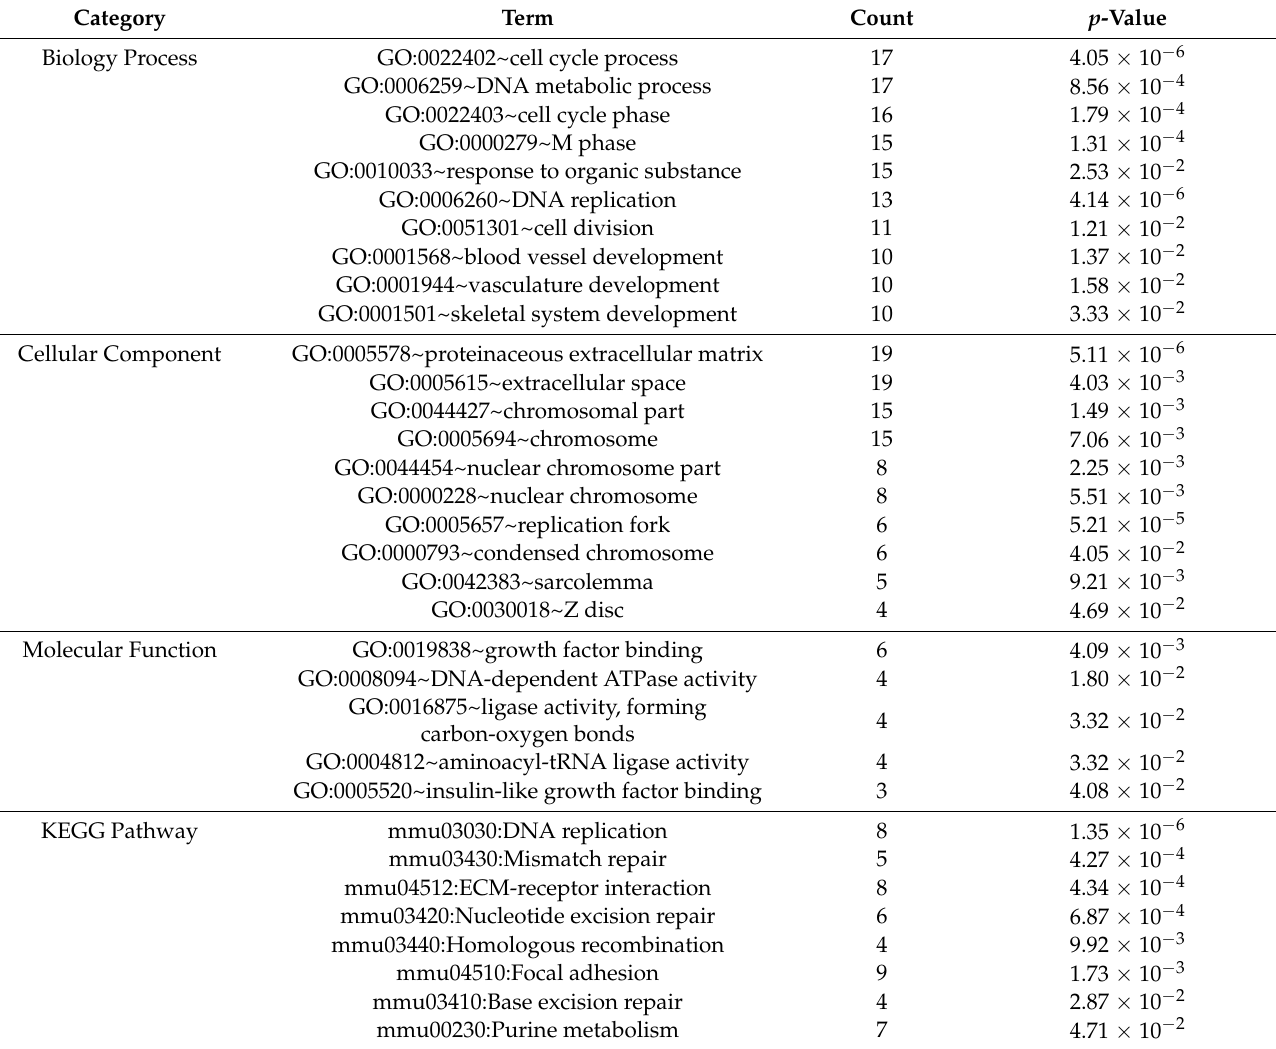
Table 1. Enriched GOs and KEGG pathways for overlapped